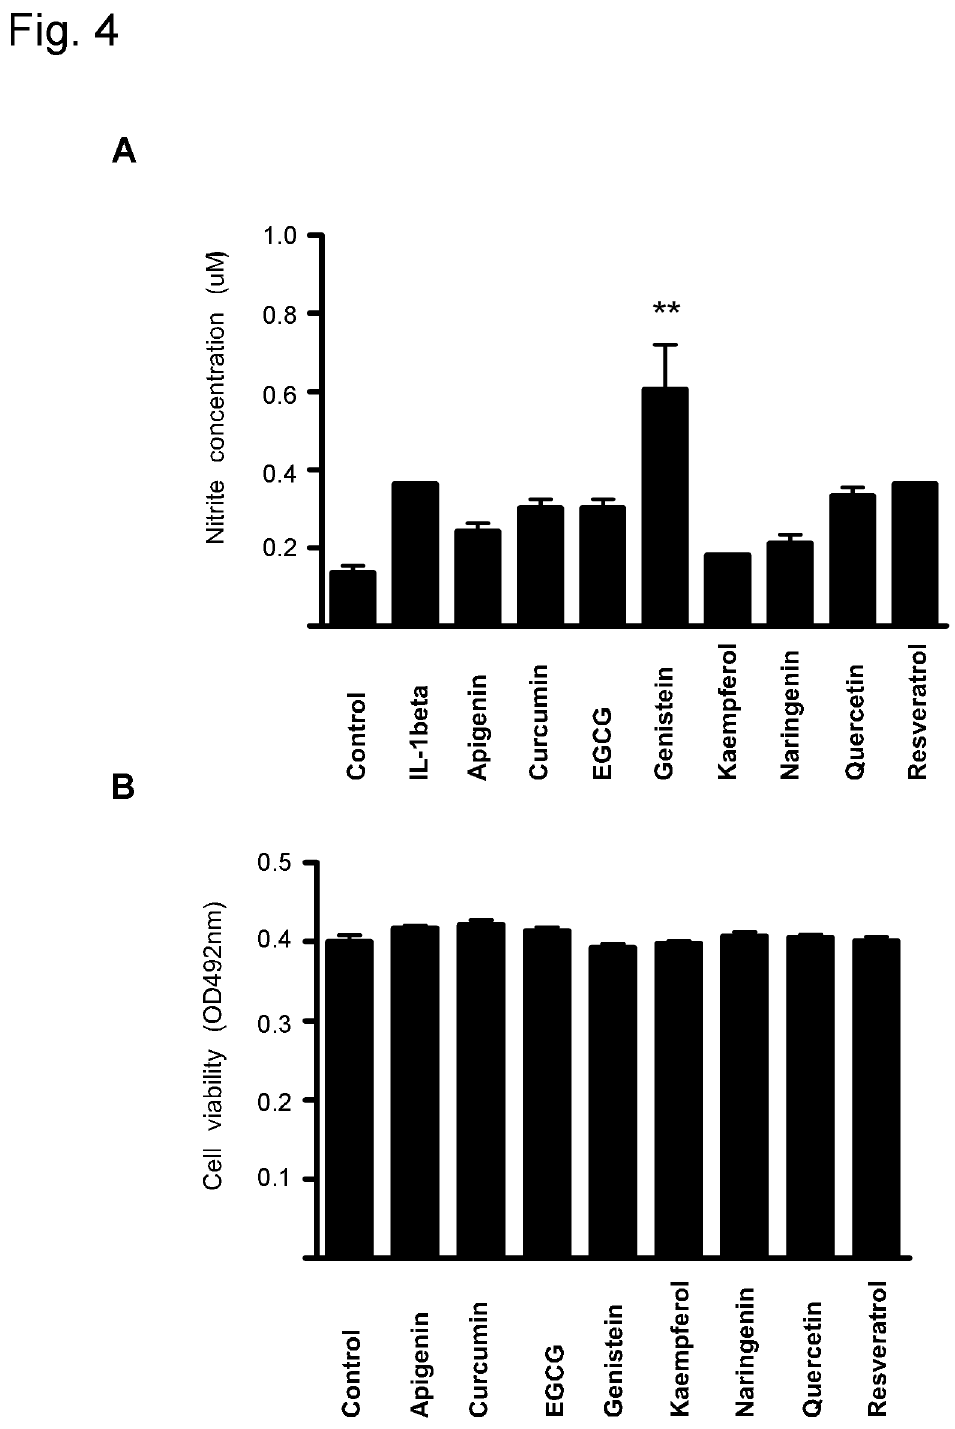
Figure 4. Effects of dietary phytochemicals on (A) nitric oxide (NO) production and (B) cell viability. NO concentration was measured as nitrite using the Nitrate/Nitrite colorimetric assay kit as described in “Materials and Methods”. Data are presented as means ± S.E.M. (n = 3) and the asterisk(s) indicate a significant (**, p < 0.01) difference versus IL-1β group. Cell viability was tested as described in “Materials and Methods”. Data are presented as means ± S.E.M. (n = 3) and the asterisk(s) indicate a significant (*, p < 0.05; **, p < 0.01; ***, p < 0.001) difference versus control (DMSO).